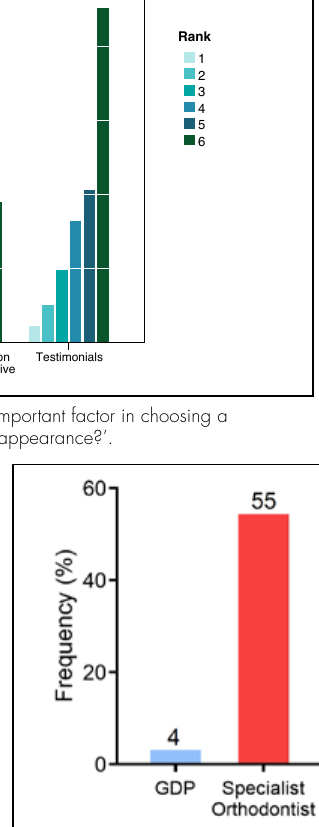
Figure 11. Frequency histogram for response to Question 6: ‘In terms of total training time, who requires more university education?’